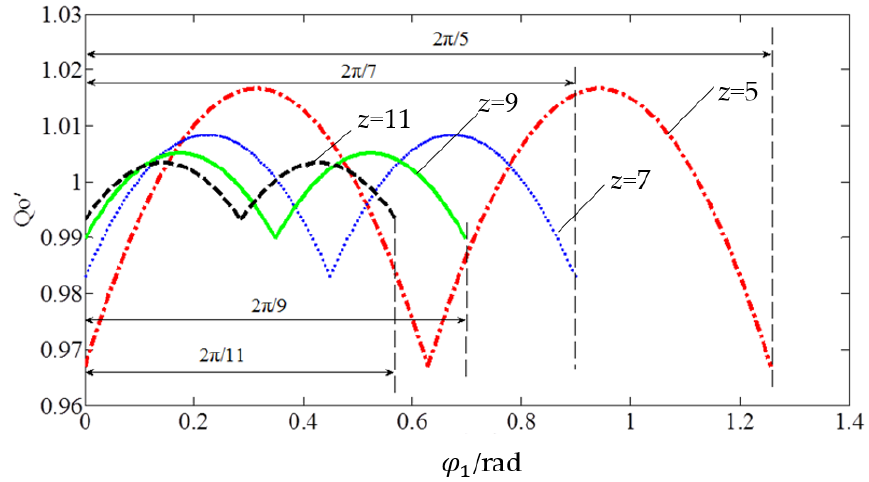
Figure 2. Output flow pulsation curve of piston pump with odd piston ( z = 5, 7, 9, 11) . For the piston pump with an even number of plungers, i.e., when z = 6, 8, 10 and 12, the output flow pulsation curve of the even number of plunger pumps under the condition of constant displacement can be obtained by programming and analysis in Matlab, as shown in Figure 3.